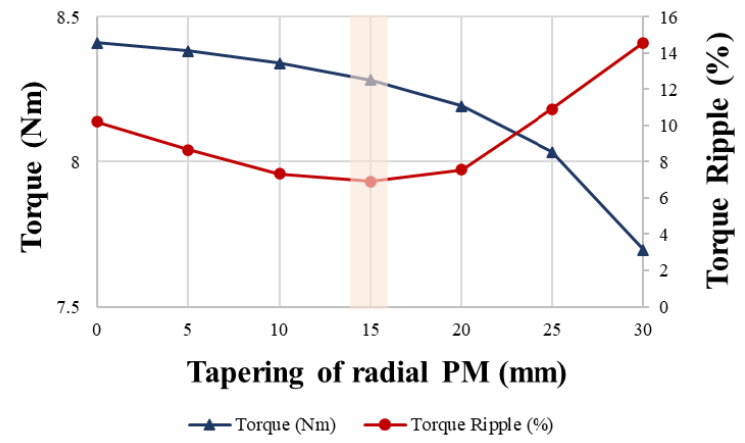
Figure 19. Torque and ripple according to tapering of radial PM.